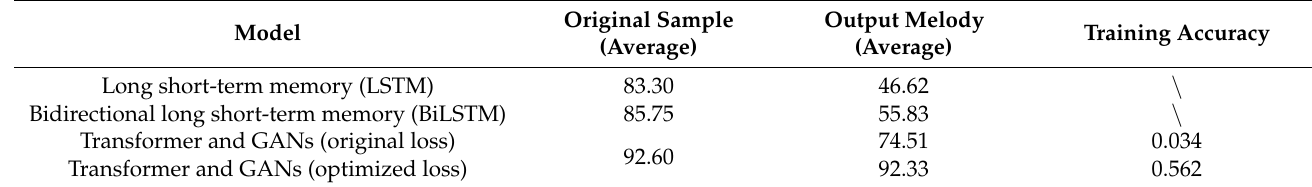
Table 4. Comparison of model